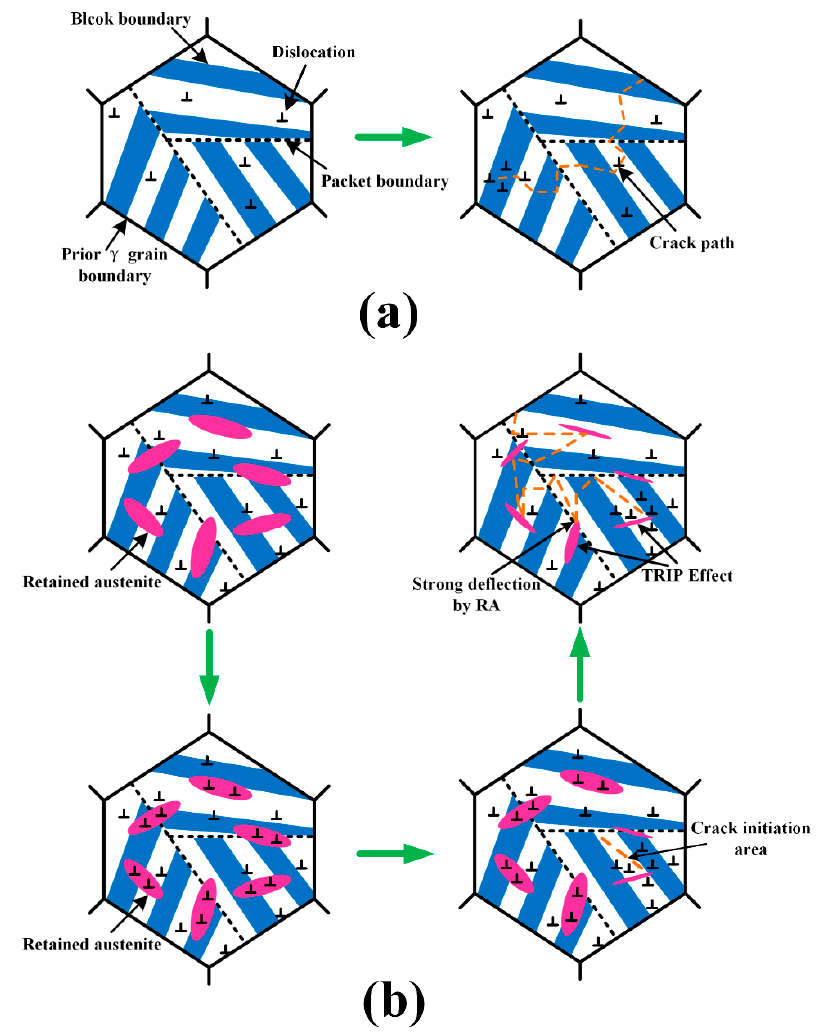
Figure 16. Schematic of the fracture path; ( a ) HHA base metal; and ( b ) Figure 16 . Schematic of the fracture path; ( a ) HHA base metal; and ( b ) weld .